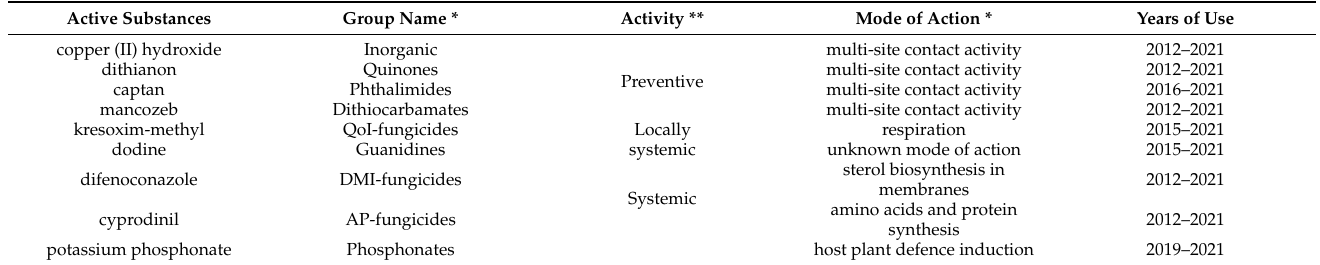
Table 2. Fungicides used against Venturia inaequalis during the 2012–2021 growing seasons.